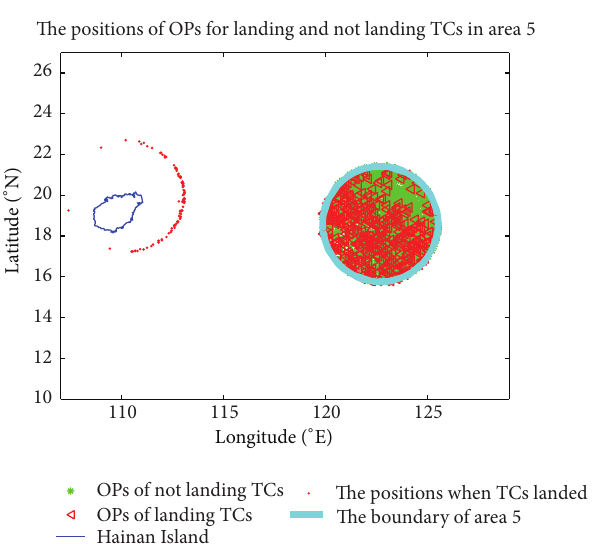
Figure 9: The positions of OPs for landing and not landing TCs which entered into each